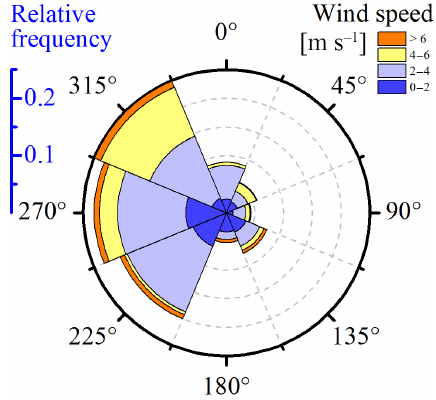
Figure 3. Wind rose based on hourly averages of wind speed and direction measured at CAO by DLI. Table 1. Thermodynamic conditions of INP analysis in